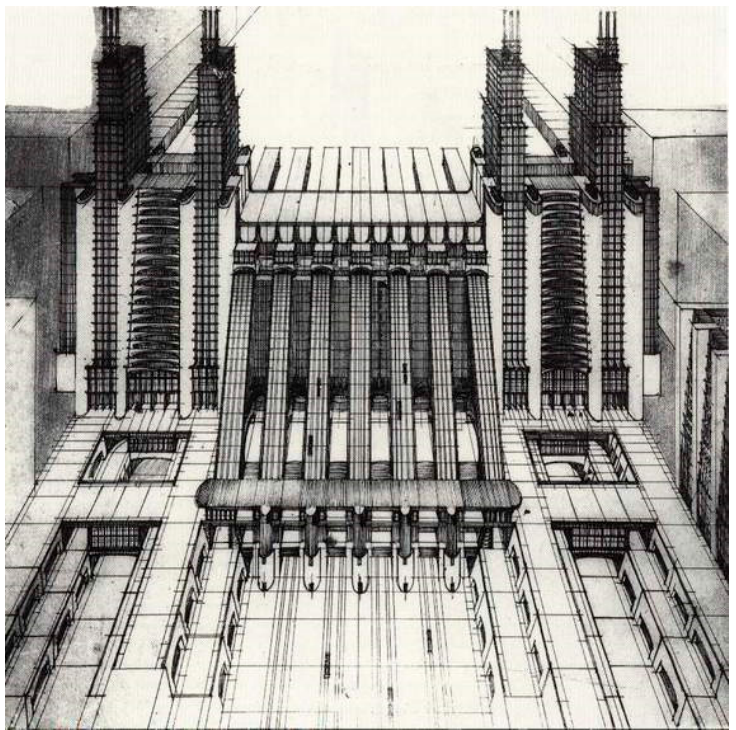
Figure 3. The multi ‐ layered futurism Città Nuova (New City) proposed by Antonio Sant’Elia, 1914. Figure 3. The multi-layered futurism Città Nuova (New City) proposed by Antonio Sant’Elia,